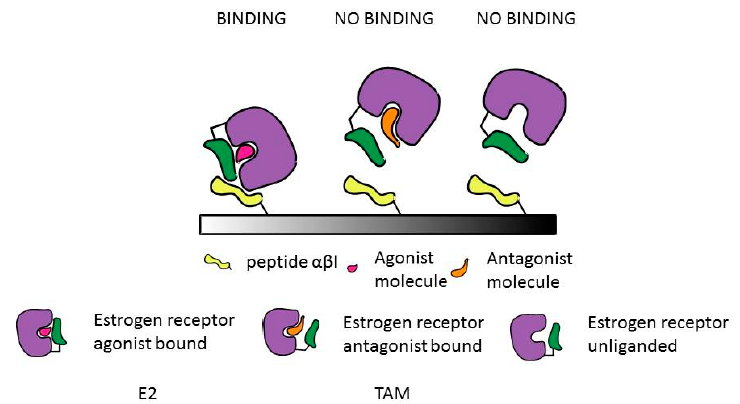
Figure 1. Schematic representation of the approach used for the detection of ER α LBD agonist and antagonist compounds.